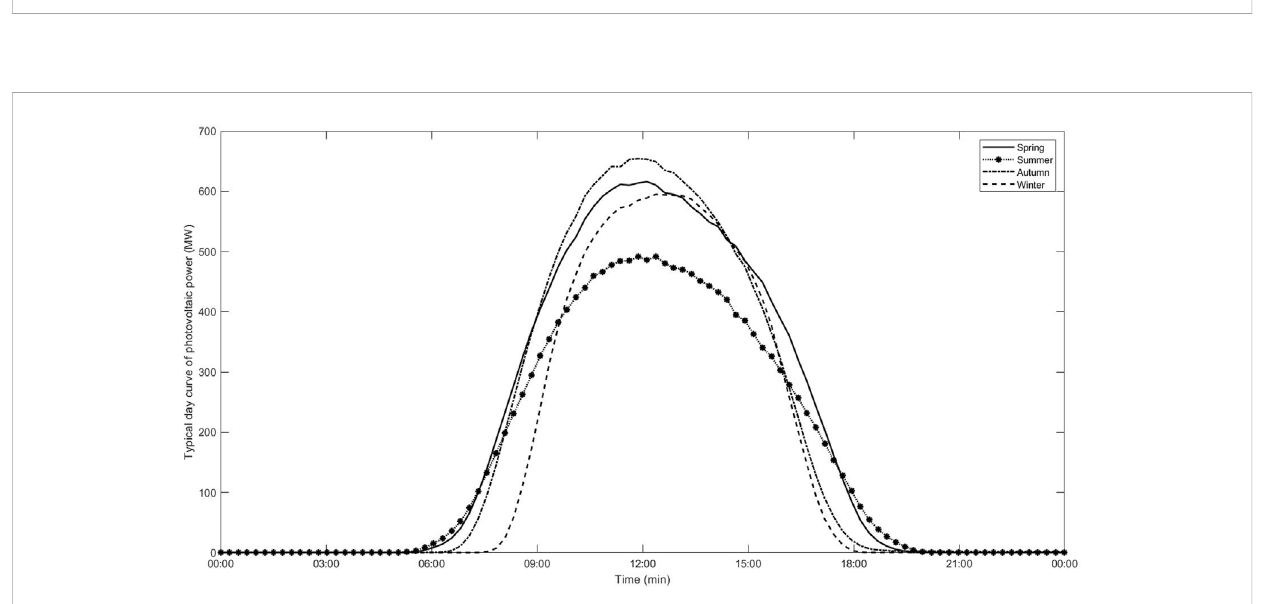
FIGURE 5 Typical day curve of photovoltaic power.